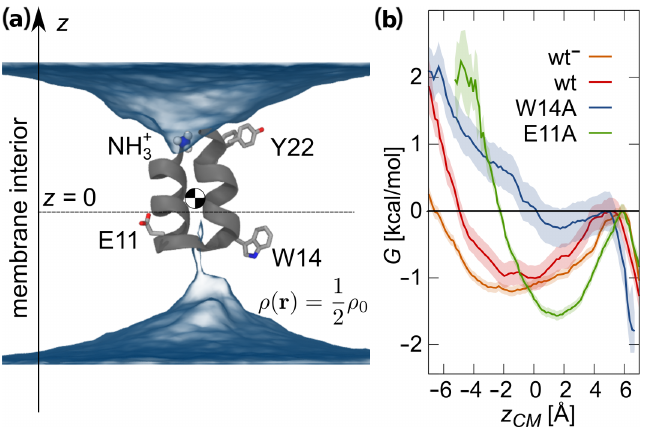
Figure 2. ( a ) Representative membrane-spanning configuration of wt HAfp with average water density isosurface at half of bulk density. ( b ) Free energy profiles for unrestrained peptides center of mass in membrane-spanning